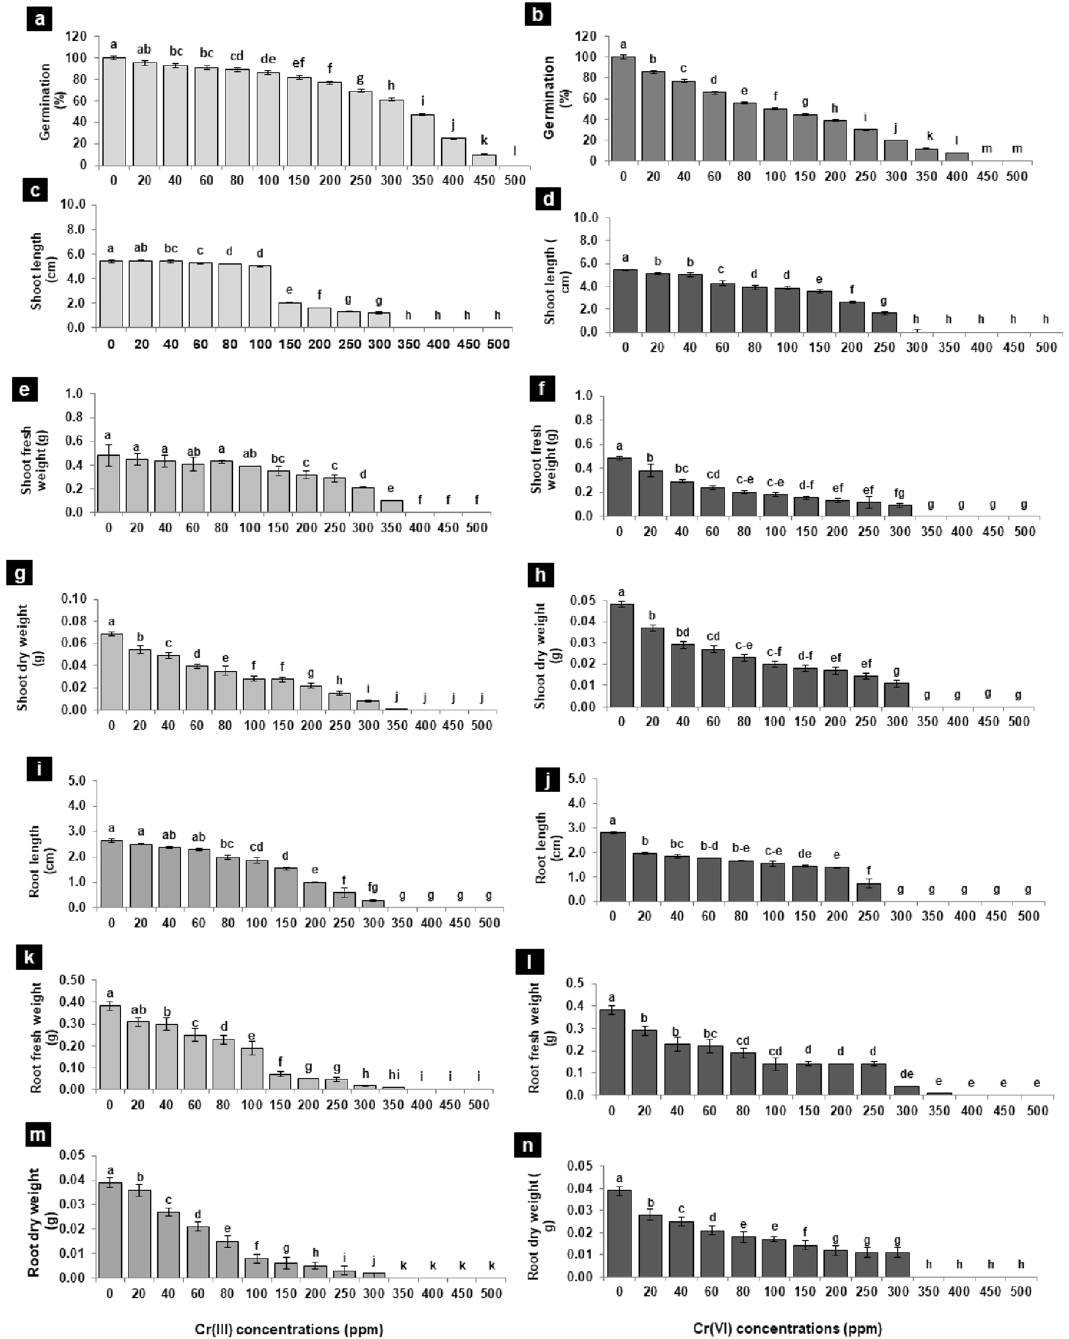
Figure 1. ( a – n ) Germination, seedling growth, and biomass of tomato due to the effect of 13 different concentrations of Cr(III) and Cr(VI) in Petri plate bioassays. Vertical bars show standard errors of the means of three replicates. Values with different letters at their top show a significant difference (p ≤ 0.05) as determined by the LSD